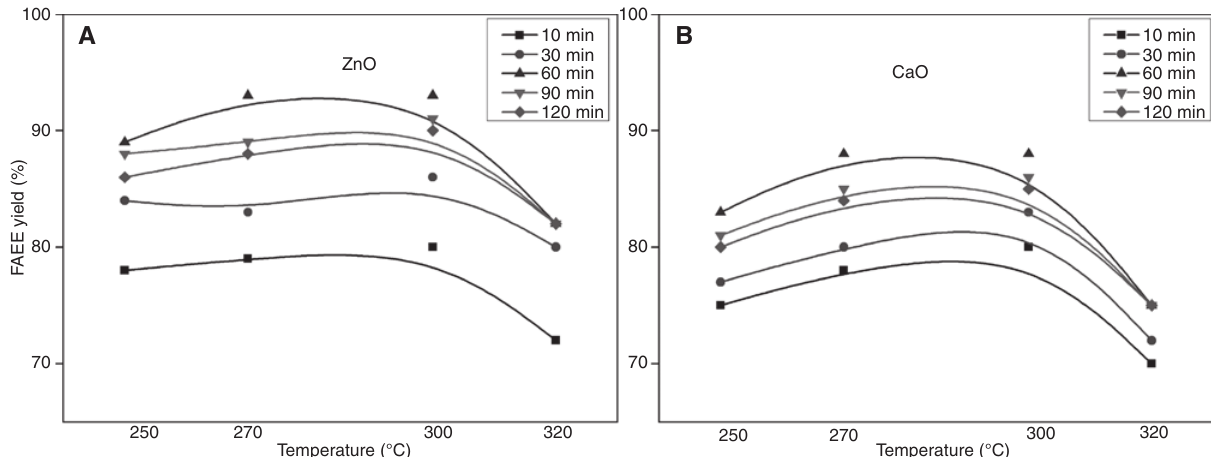
Figure 12: FAEE yield as function of temperature at different reaction time of ZnO (A) and CaO (B) (reaction conditions: catalyst amount = 3%, molar ratio 42/1).